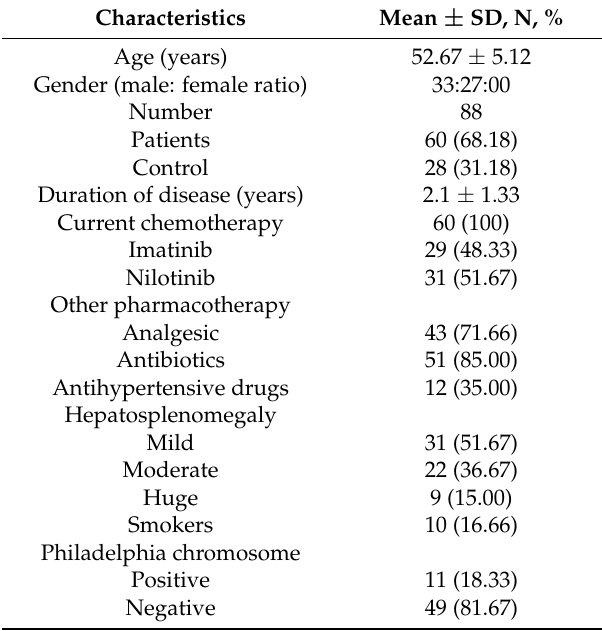
Table 1. characteristics of the